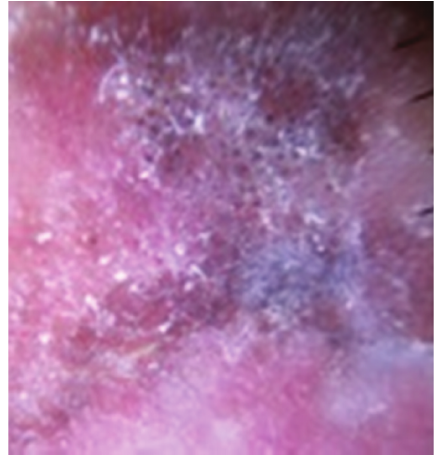
Figure 9: Case 2. Closeup view of clusters of regular pigment globules and glomerular vessels in a linear arrangement. Central area shows brown and blue-gray structureless areas and keratosis.